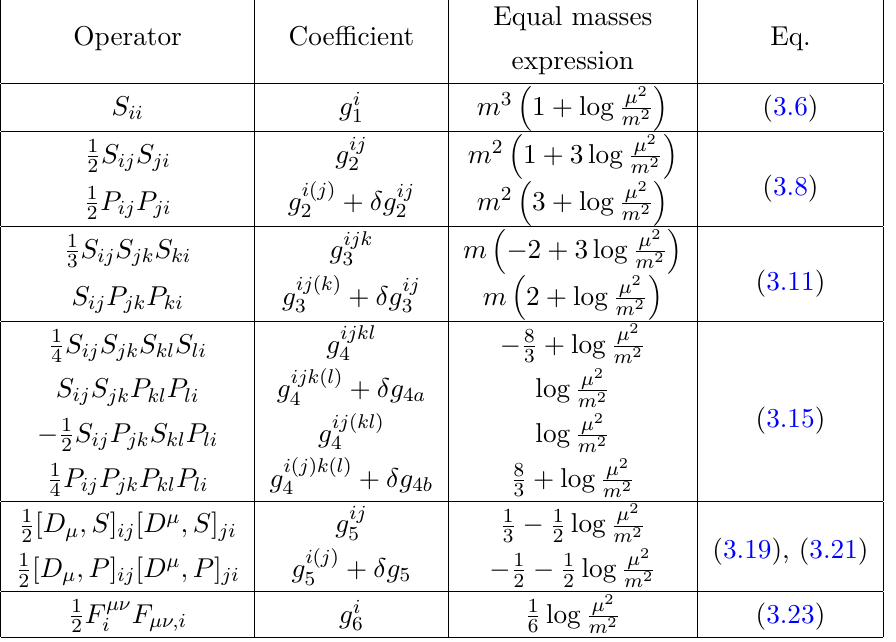
Table 1 . Values of the dimension ≤ 4 fermionic universal coefficients in the limit of equal masses.